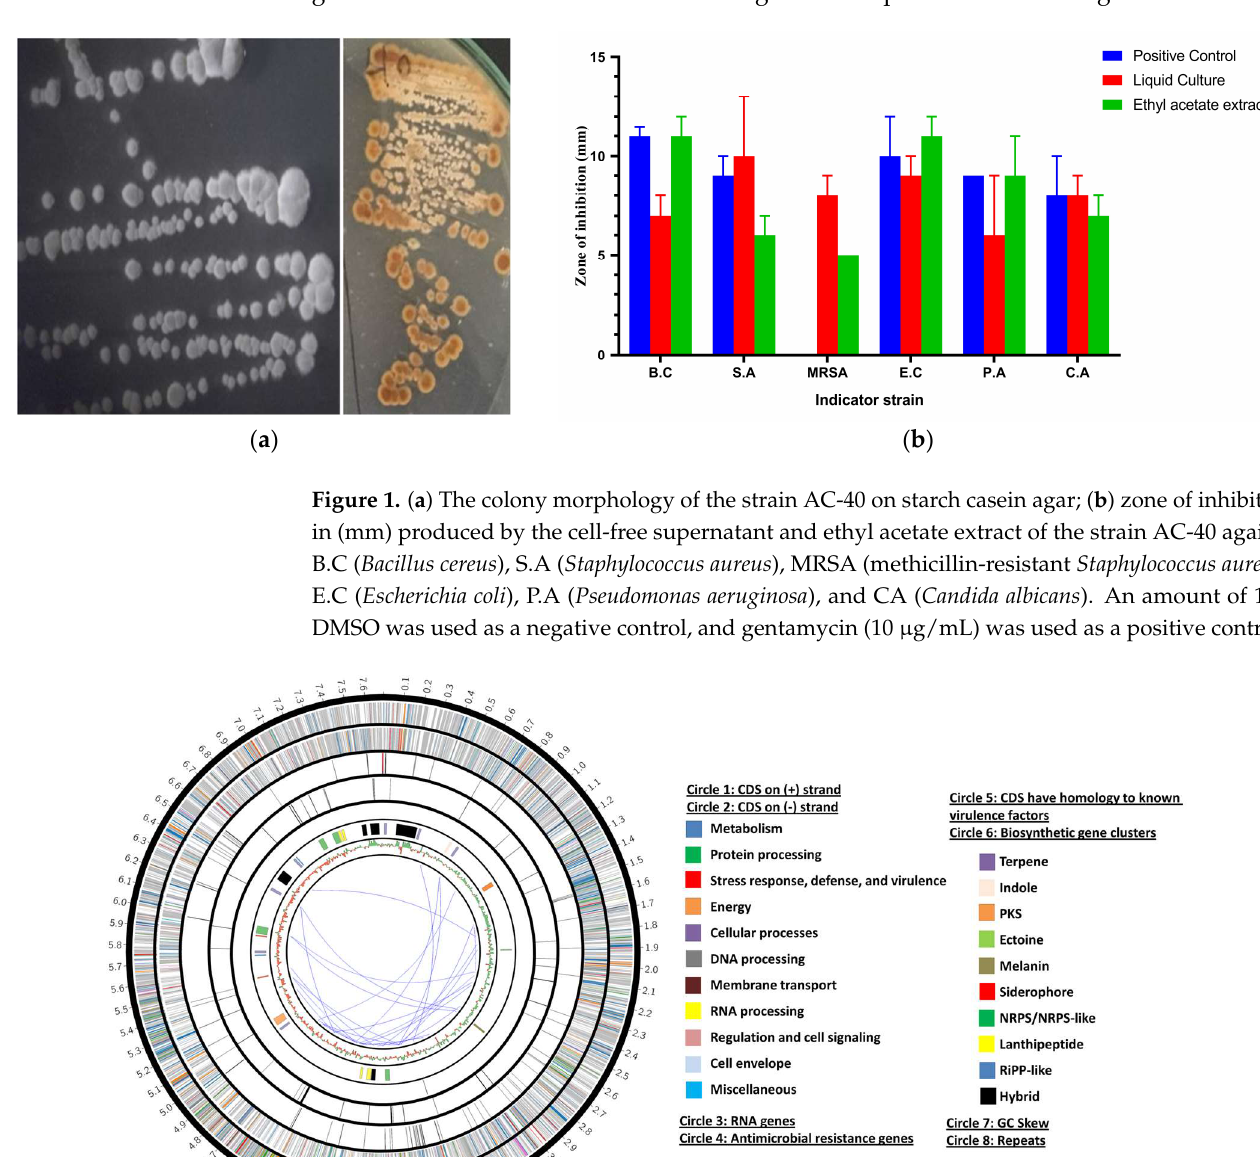
Figure 2. A circos diagram represents the genome map of the strain AC-40’s bacterial chromosome indicating the RAST, AntiSMASH annotations, GC Skew, and the repeated regions.